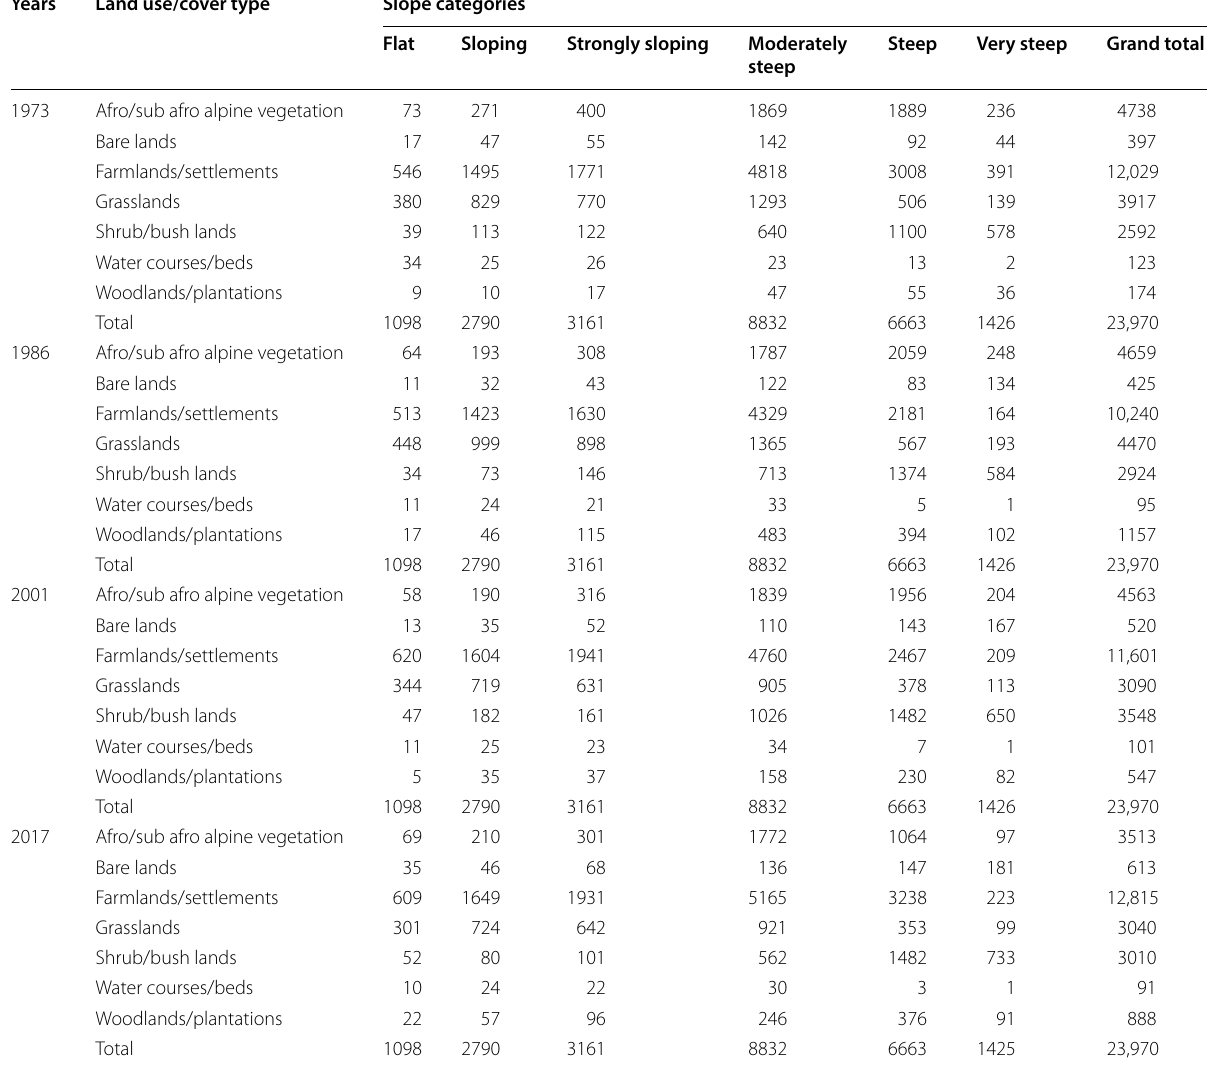
Table 10 LULC types based on slope categories in Gedalas watershed